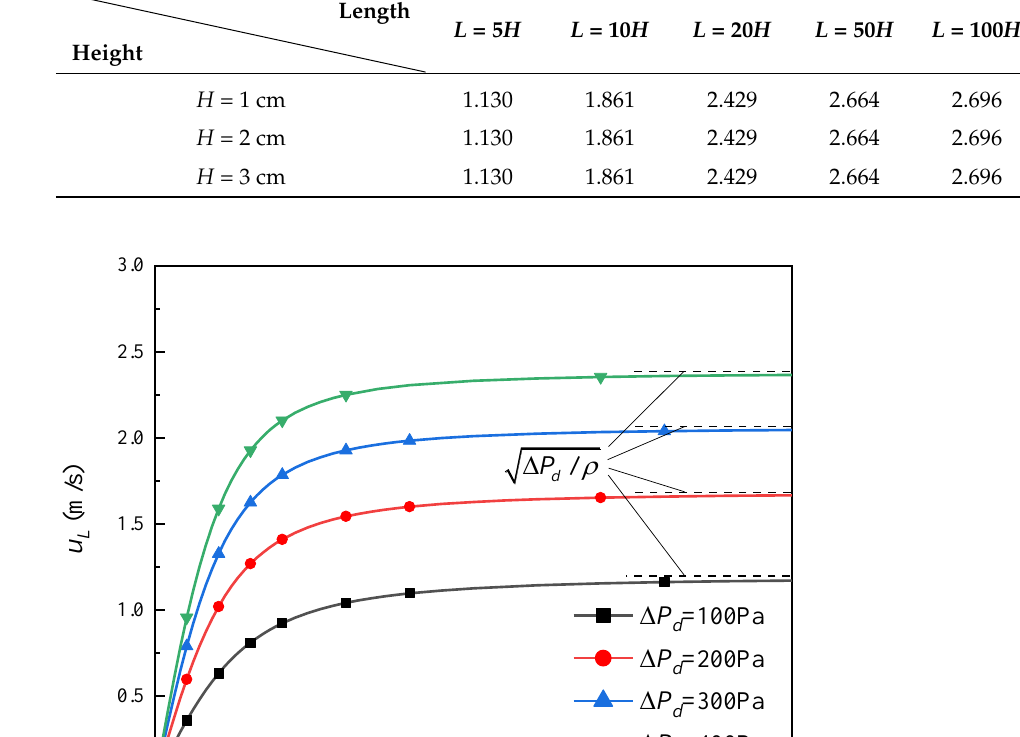
Table 1. (m/s) of channels with different sizes (screen: DTW325 × 2300; ∆ P d = 519 Pa).